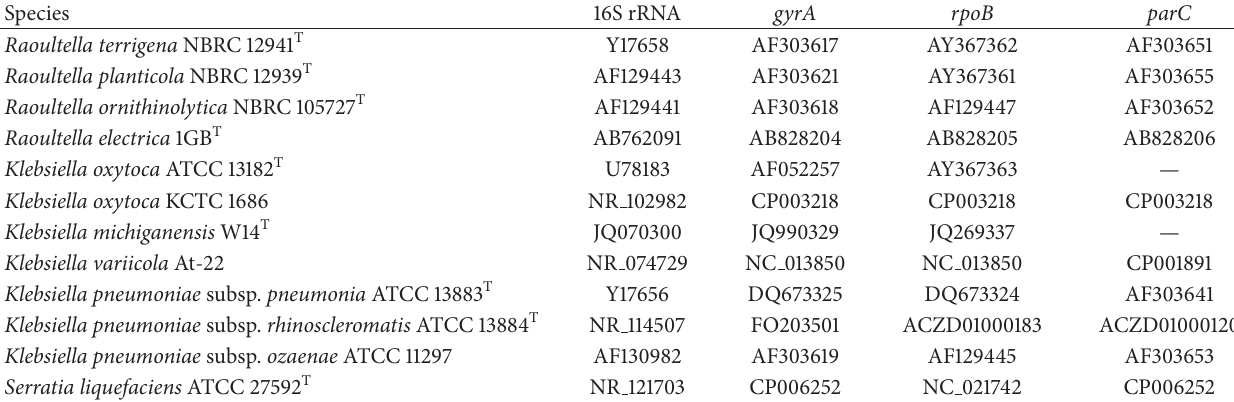
Table 2: The list of gene sequences used for phylogenetic tree